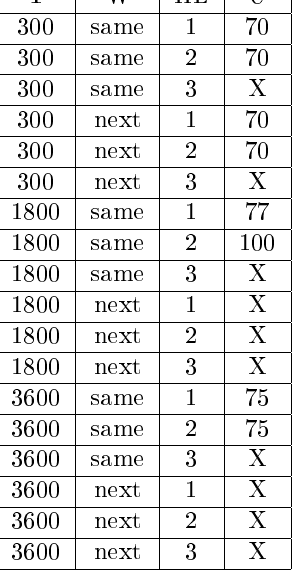
Tab. 3: Result of Backup